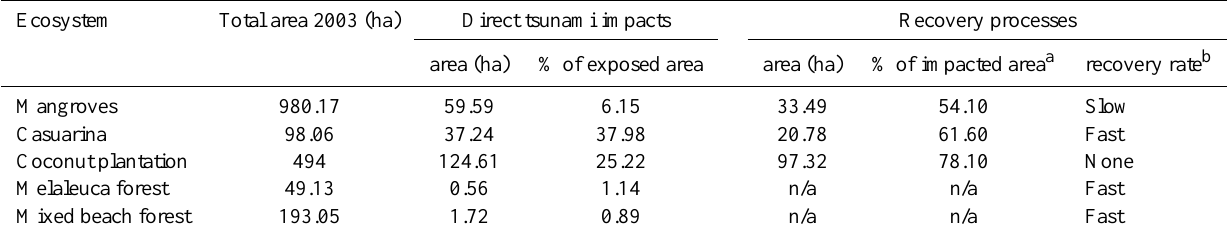
Table 3. Damage and recovery rates of coastal forests in the study area (derived from remote sensing techniques). Ecosystem Total area 2003 (ha) Direct tsunami impacts